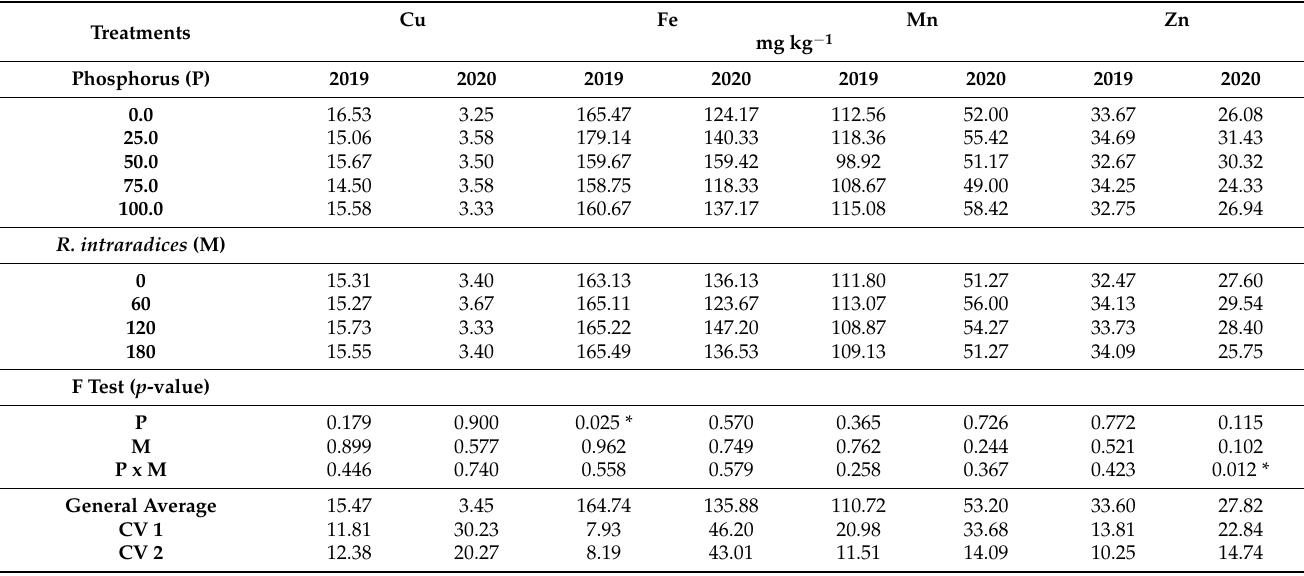
Table 4. Micronutrient foliar contents in corn at flowering as a function of P 2 O 5 doses and seed inoculation with Rhizoglomus intraradices